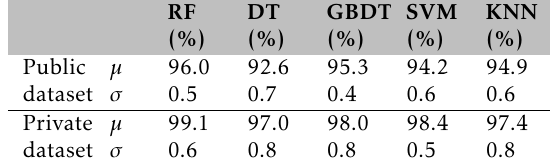
Tab 5. Evaluation of recognition models with 5-fold cross- validation.